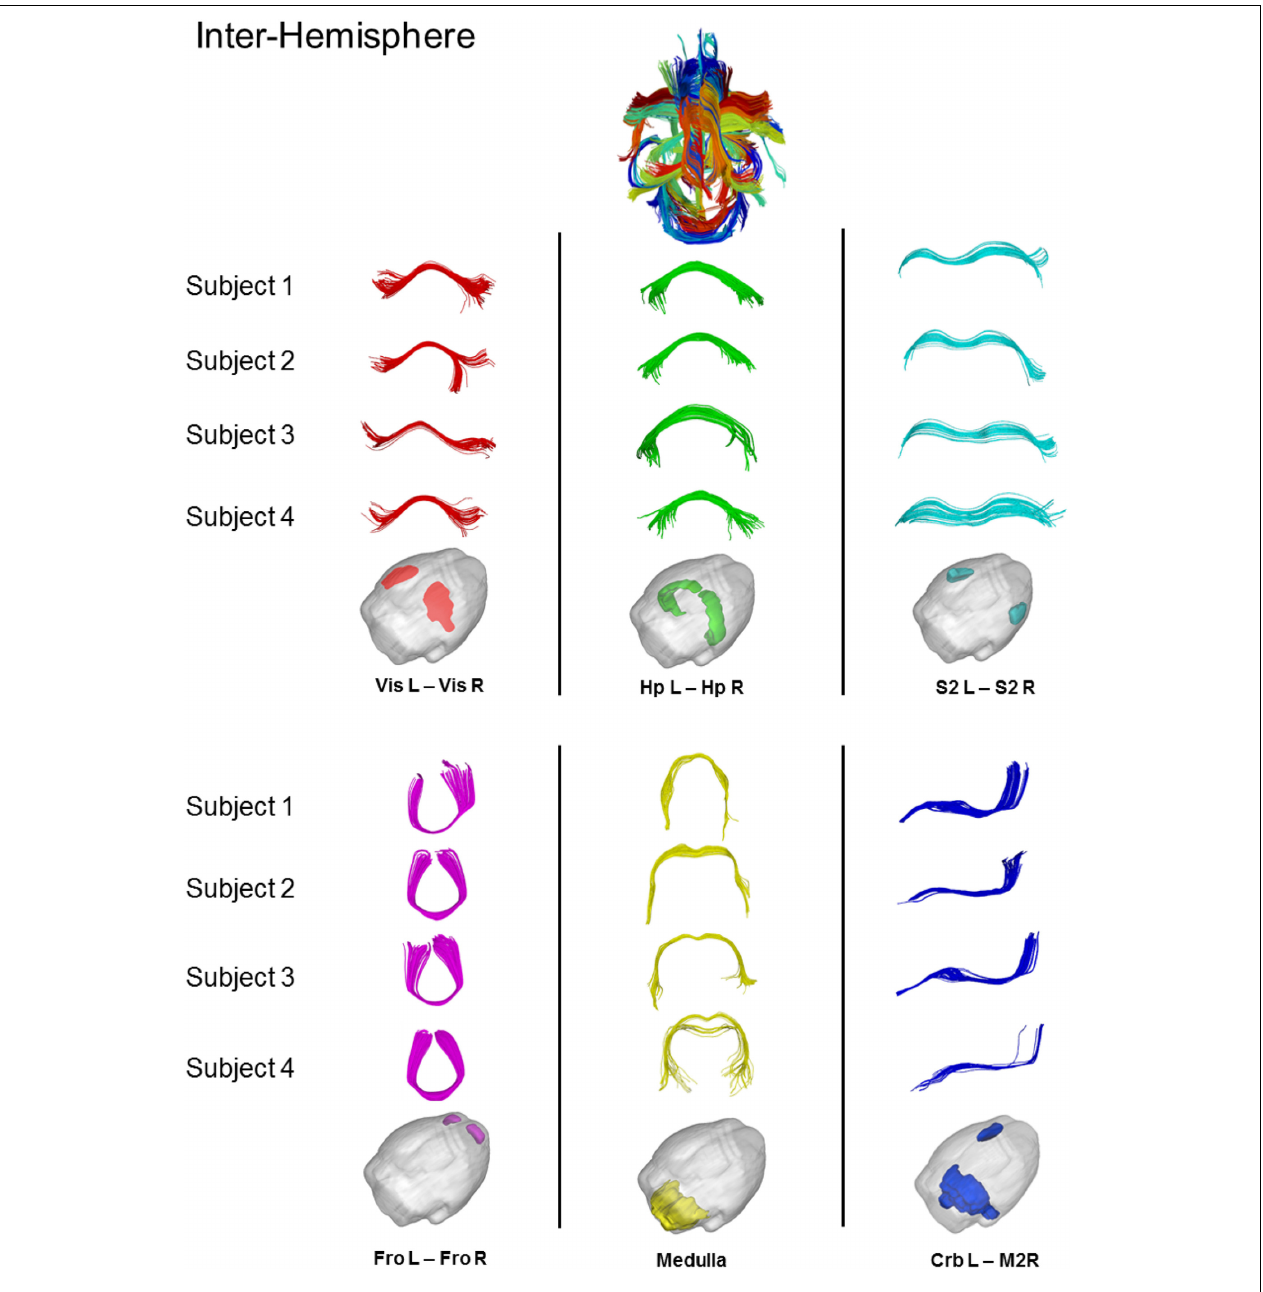
FIGURE 7 | Results of cross-subjects clustering on inter-hemispheric fibers and magnification of some significant white matter bundles. For each significant bundles, we show four random subjects. Red = Dorsal Hippocampal Commissure, Green = Hippocampal Commissure, Cyan =